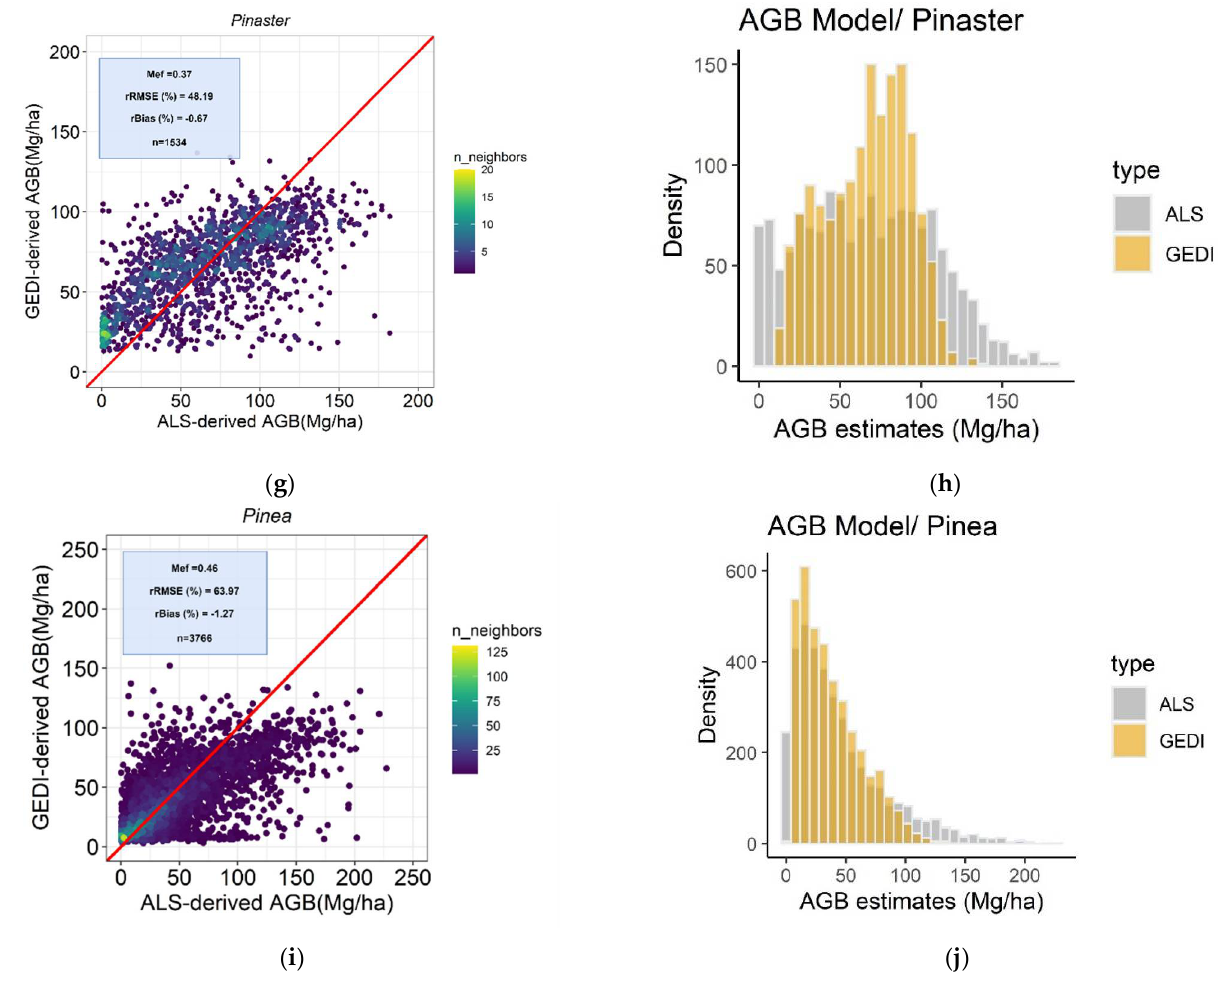
Figure 4. Scatterplots of ALS observed vs. GEDI-estimated at GEDI footprint level values of AGB for the best model in terms of rBias and associated histogram: ( a , b ) Dehesas ; ( c , d ) Encinares ; ( e , f ) Alcornocales; ( g , h ) Pinaster ; ( i , j ) Pinea , canopy. The red solid line represents the 1:1 relationship.